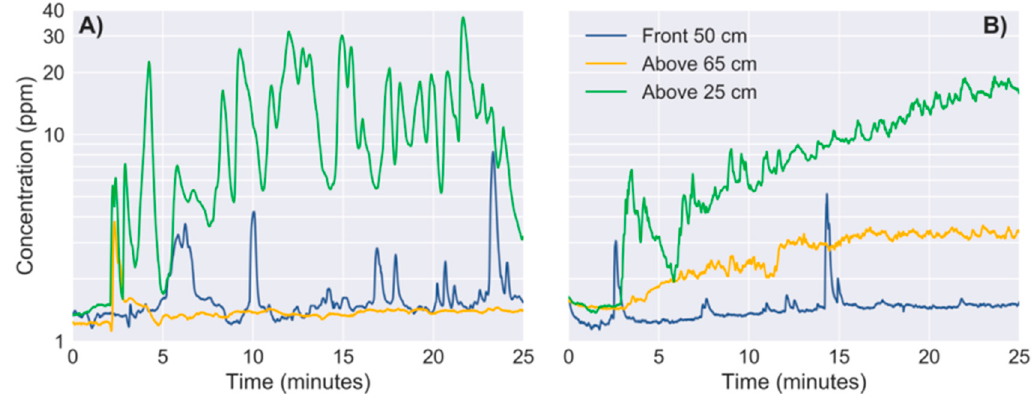
Figure 12. Sensor signals (log scale) near an evaporating source. ( A ) Propellers switched off; ( B ) Propellers switched on. The ethanol bottle is opened at t = 2 min.